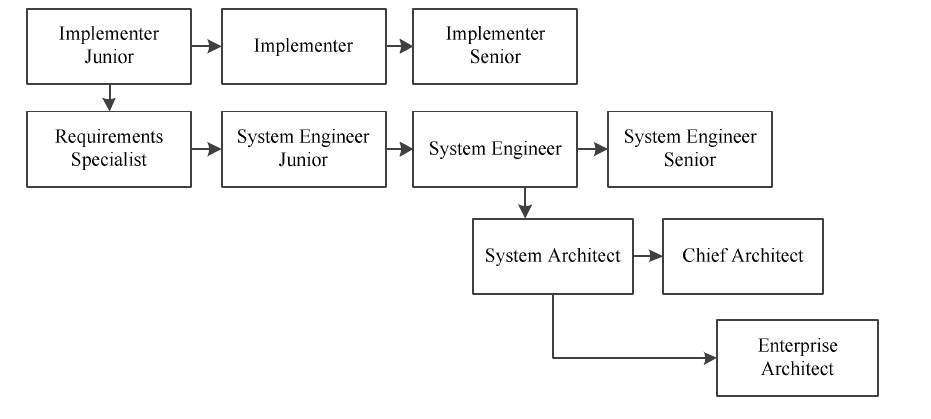
Figure 2 – Career Path of the Enterprise Architect Role source: (SEICMU,